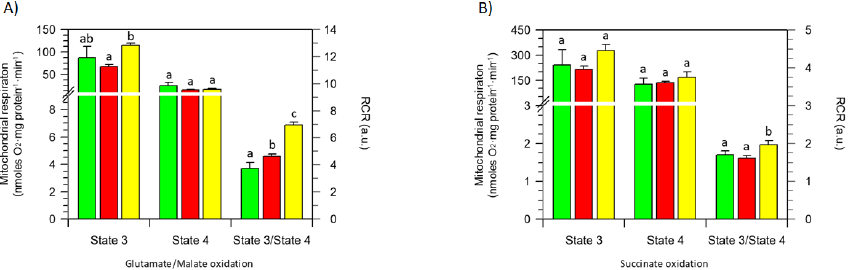
Figure 2. BPF effects on selected oxidative phosphorylation parameters: state 3 and 4 respiration rates and their ratio as the RCR. Glutamate/malate- ( A ) and succinate- ( B ) stimulated mitochondrial respiration in the presence of 50 µg/mL (red) ( █ ), 100 µg/mL (yellow) ( █ ), and in the absence (green) ( █ ) of the BPF, respectively. Data expressed as columns represent the mean ± SD from three inde- pendent experiments carried out on different mitochondrial preparations. Different letters indicate significant differences ( p ≤ 0.05) among treatments within the same parameter (state 3; state 4, and state 3/state 4).